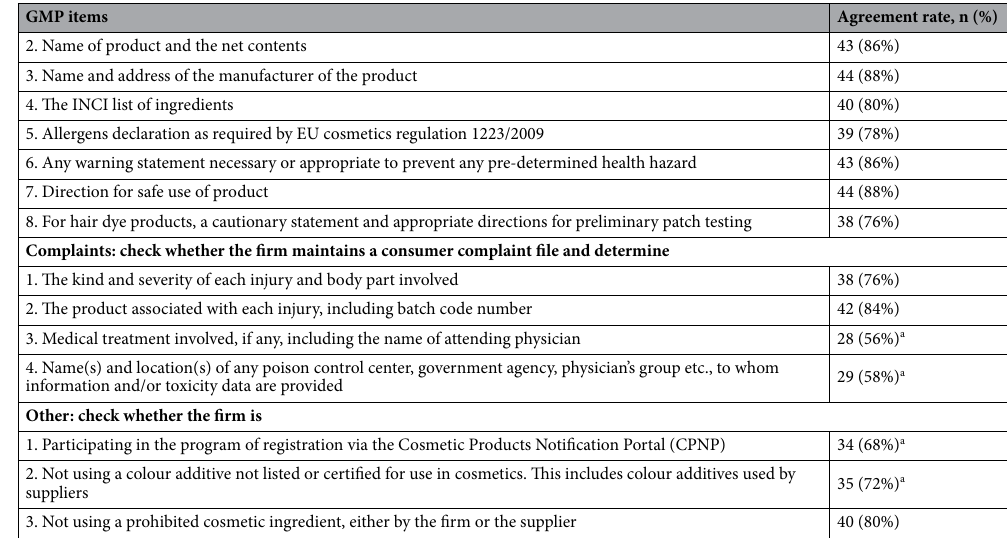
Table 2. Experts’ agreement rating of the GMP: ISO 22716: questionnaire items (n = 50). a Agreement rate below the pre-defined criteria and item excluded from the final audit preparation tool.